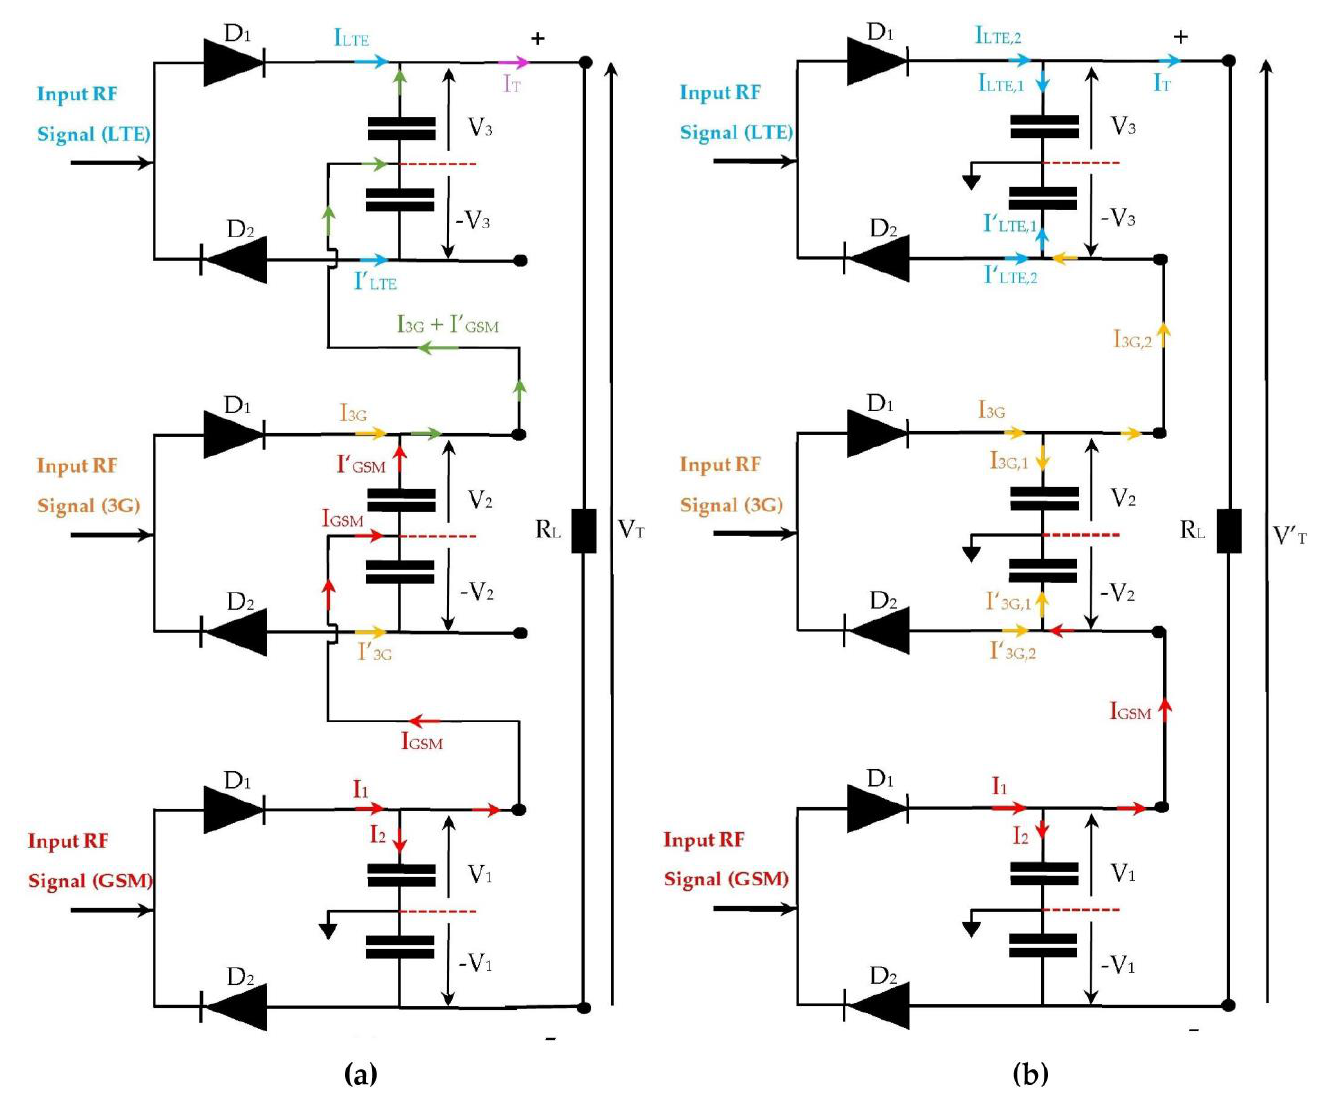
Figure 29. Current flow for both architectures. ( a ) First architecture, ( b ) Second architecture .